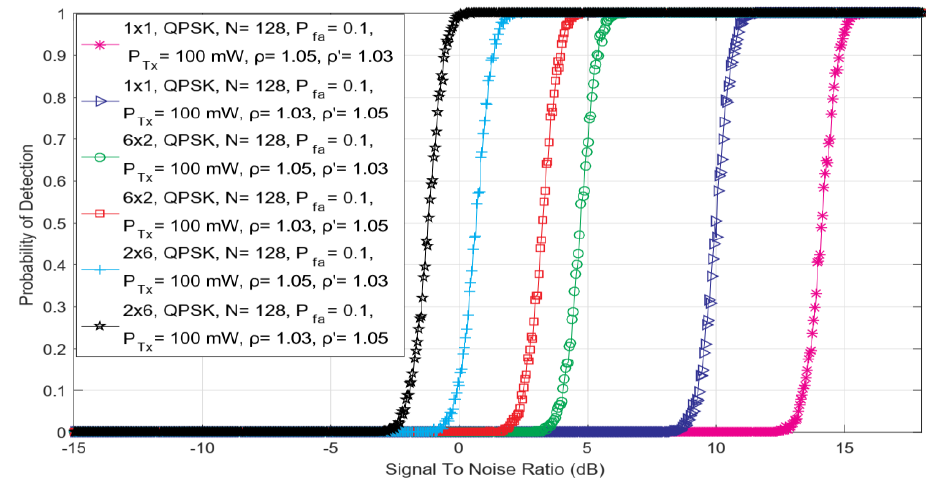
Figure 5. The dependency of detection probability on SNR for ED performed with versatile combinations of DDT and NU factors in SISO and asymmetric communication MIMO 2 × 6 and 6 × 2 systems.